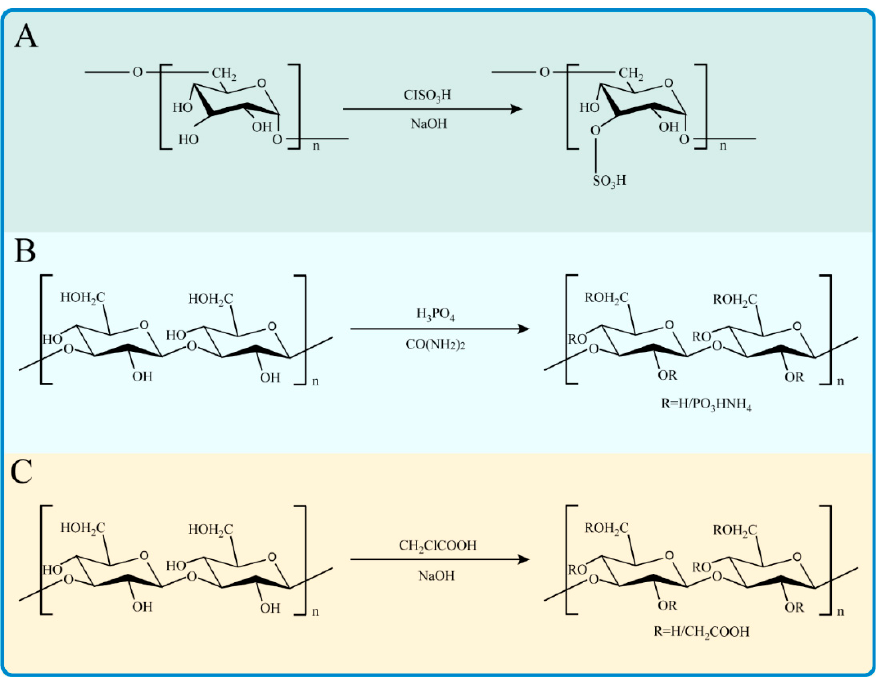
Figure 4. Several common modification methods and schematic diagrams of natural polysaccha- rides. ( A ) Sulfation modification with CSA; ( B ) Phosphorylation modification with phosphoric acid; ( C ) Carboxymethylation modification with monochloroacetic